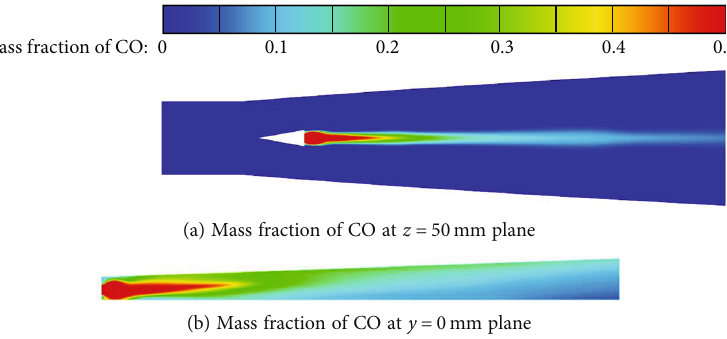
Figure 14: Distribution of mass fraction of CO.